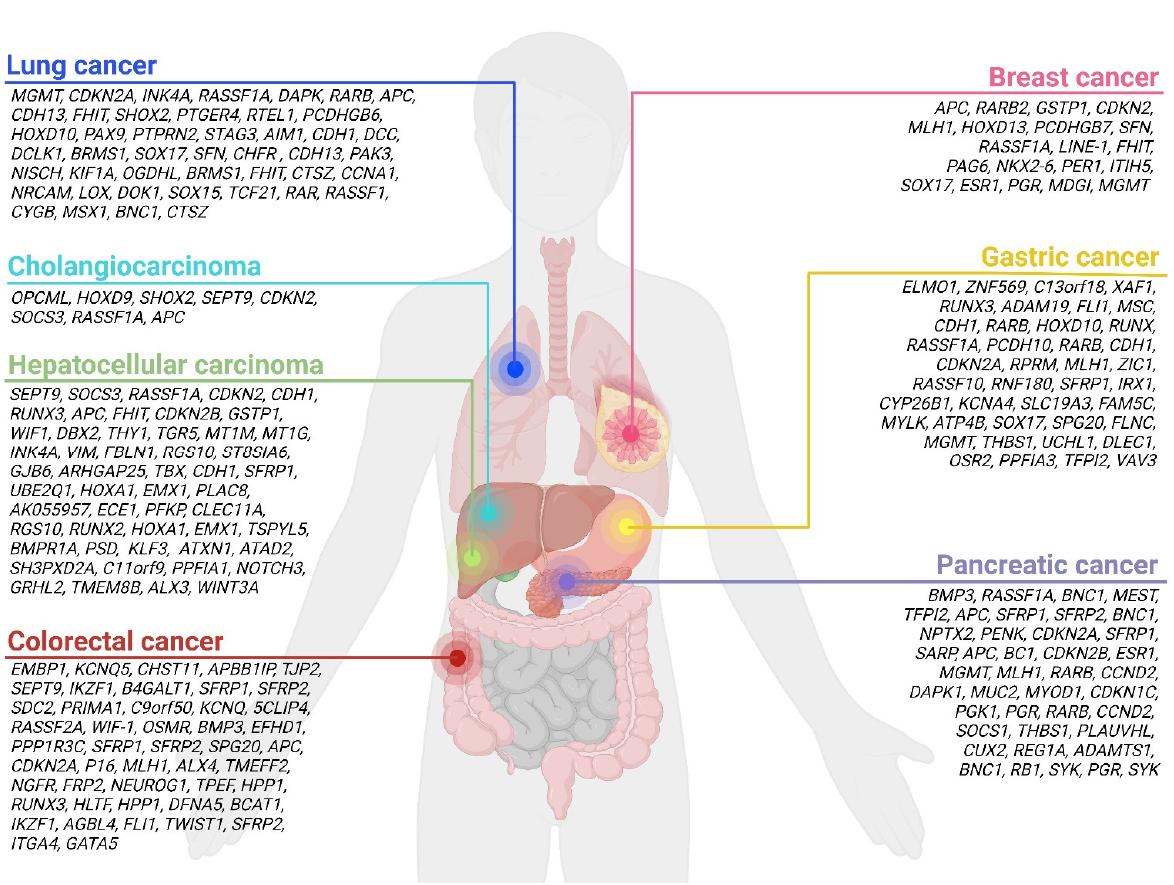
Figure 1. Overview of aberrantly methylated genes detected in patients with the most common pri- mary malignant liver tumors and malignant tumors that most commonly metastasize to the liver. Created with BioRender.com.